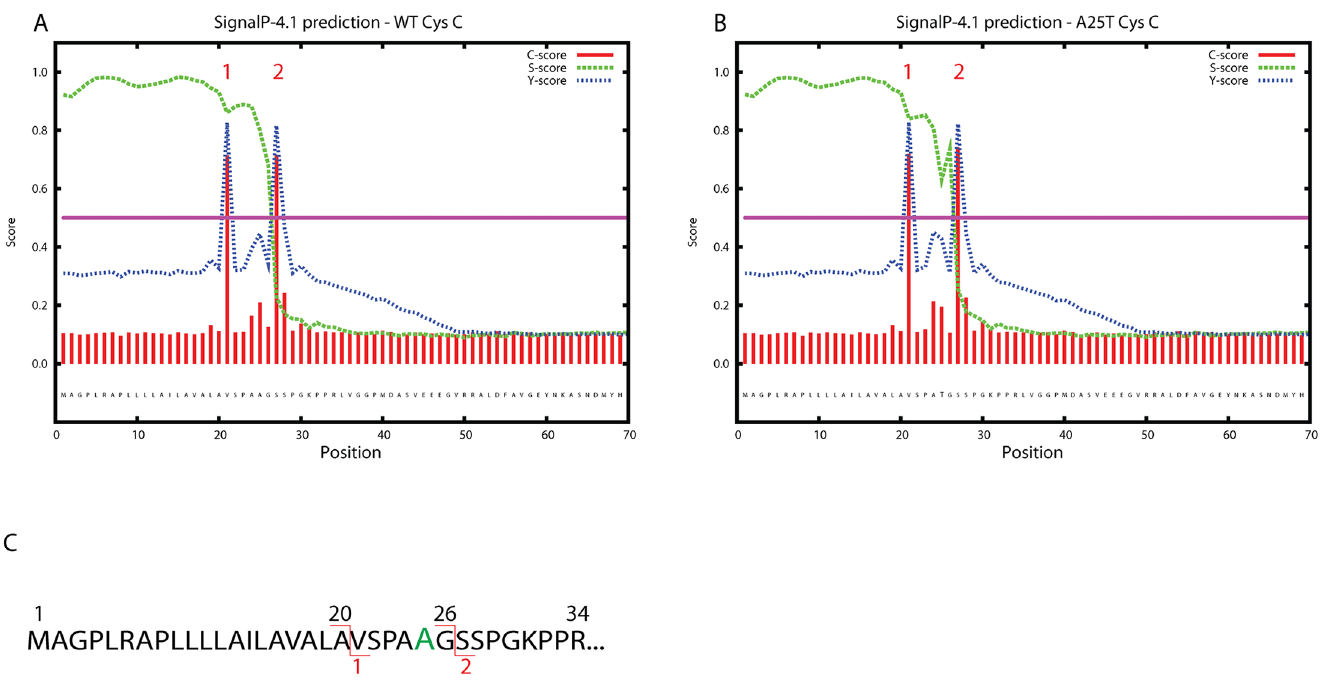
Fig 3. Signal sequence prediction of WT and A25T Cys C using SignalP 4.1 software. (A, B) WT and A25T Cys C amino acid sequence was analyzed by SignalP 4.1 software and the resultant predicted cleavage sites, designated as site 1 and site 2, are shown. (C) In WT Cys C, site 1 cleavage occurs between Ala20 and Val21, site 2 cleavage occurs between Gly26 and Ser 27. The Ala residue in the A25T mutation is enlarged and colored green.